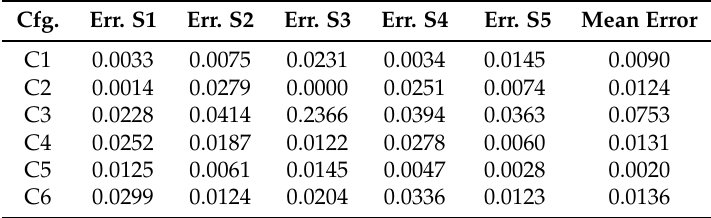
Table 5. Errors of the predicted energy consumption compared to the measurements.